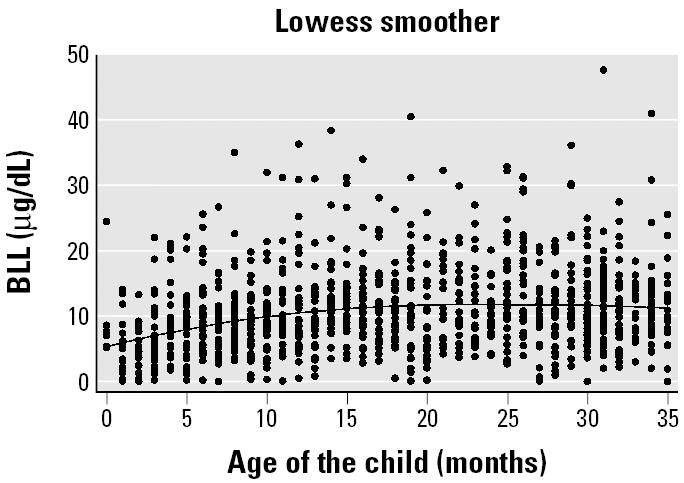
Scatter plot and smoothed line of BLLs (n = 1,078) by age of the child for children < 3 years of age in Mumbai and Delhi, India (bandwidth = 0.8).